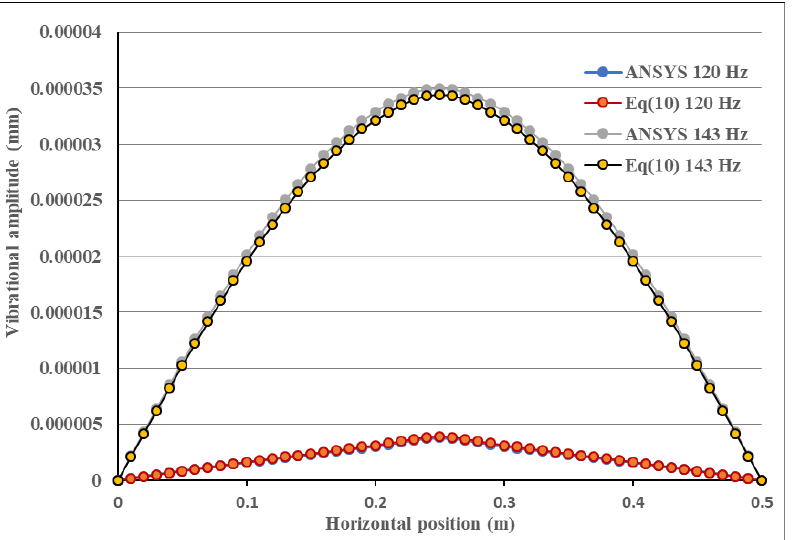
Figure 5. Vibrational amplitude distribution along the horizontal line (y = 0.25 m) of the composite laminate plate for the excitation frequencies of 143 Hz and 120 Hz.